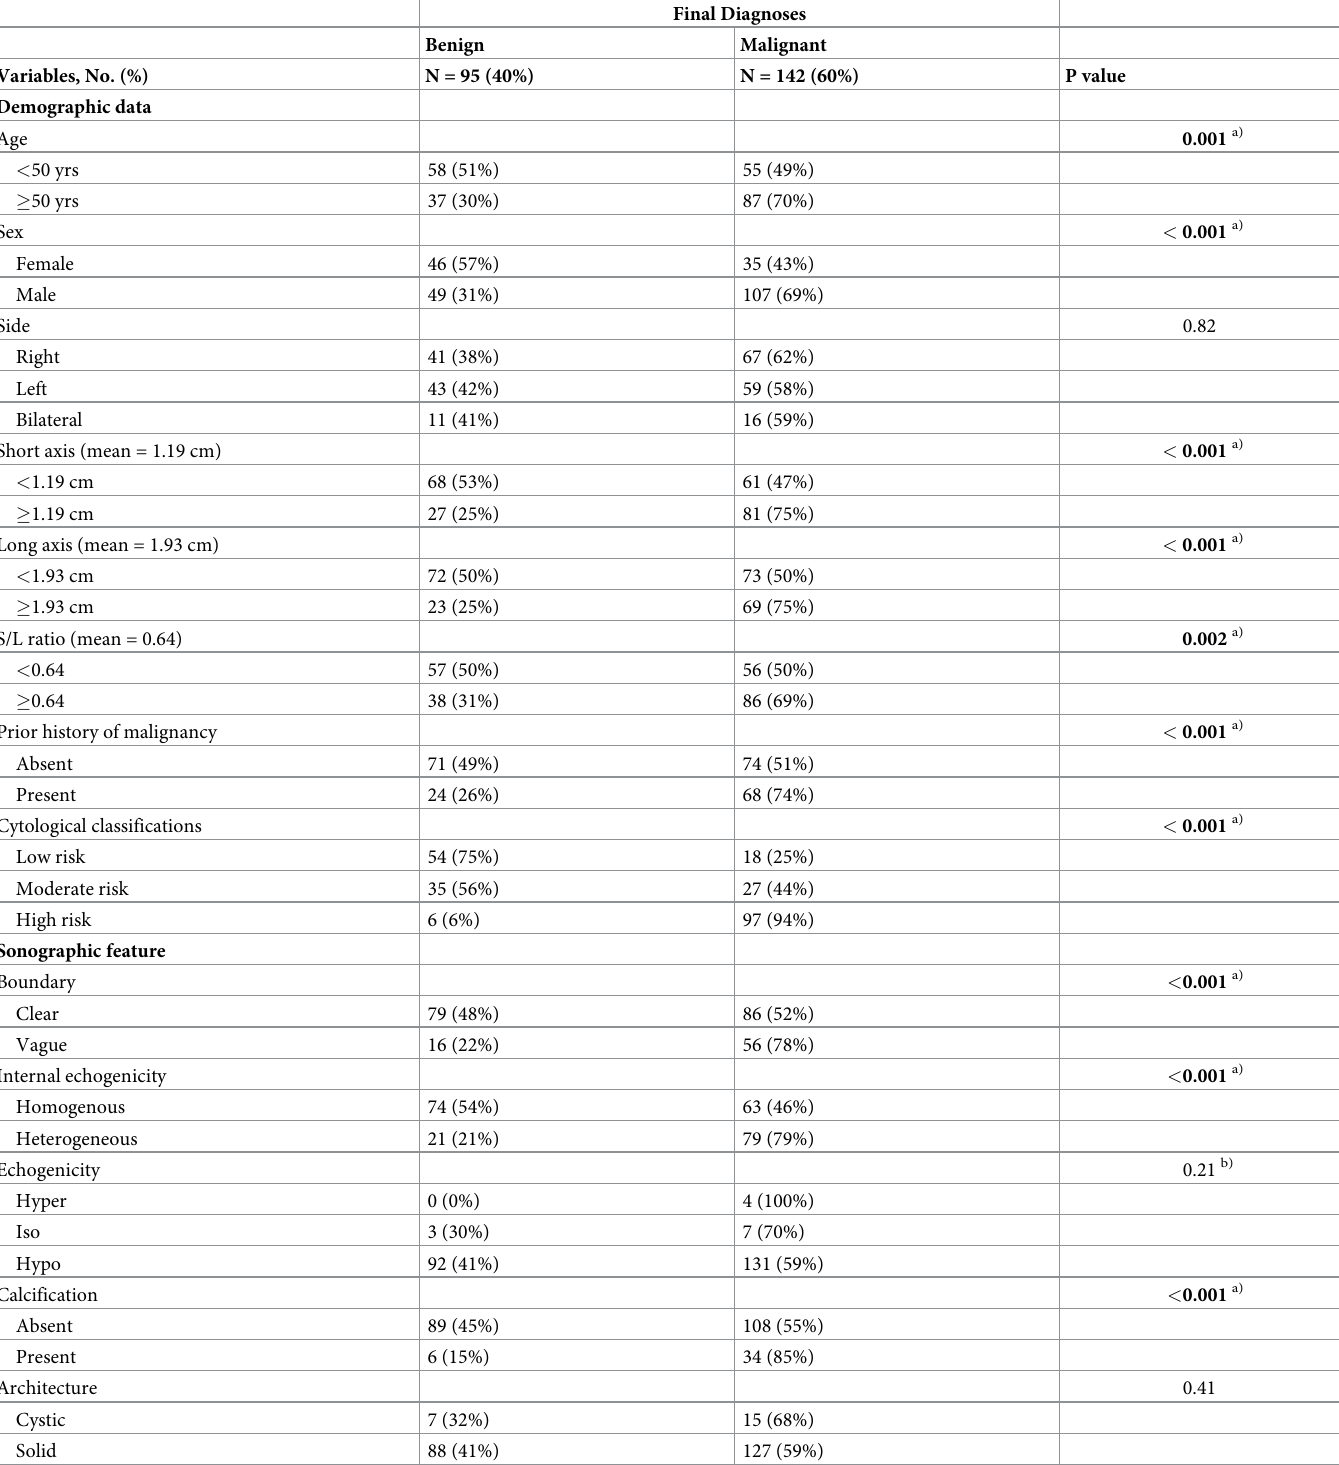
Table 2. Comparison of demographic and sonographic features between patients with benign and malignant final diagnoses from neck LNs with indeterminate cytology.